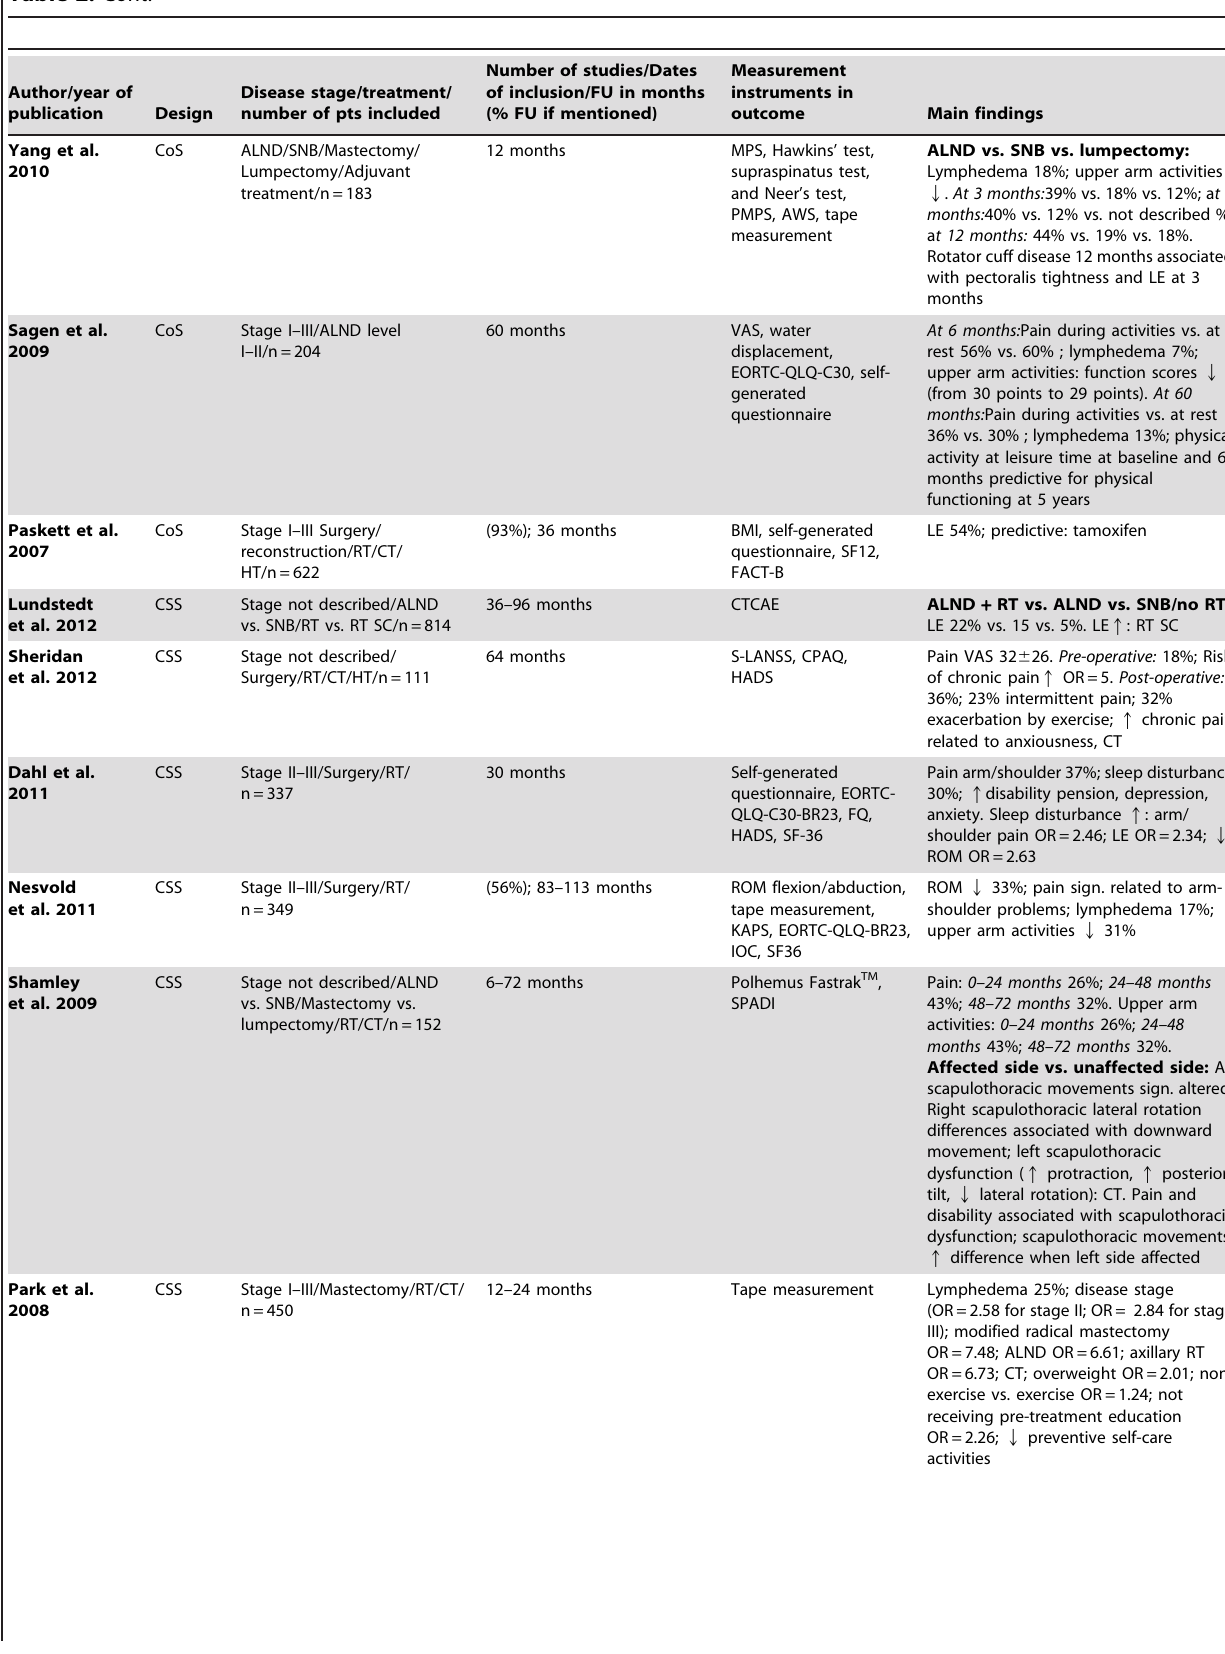
upper arm activities: function scores Q (from 30 points to 29 points). At